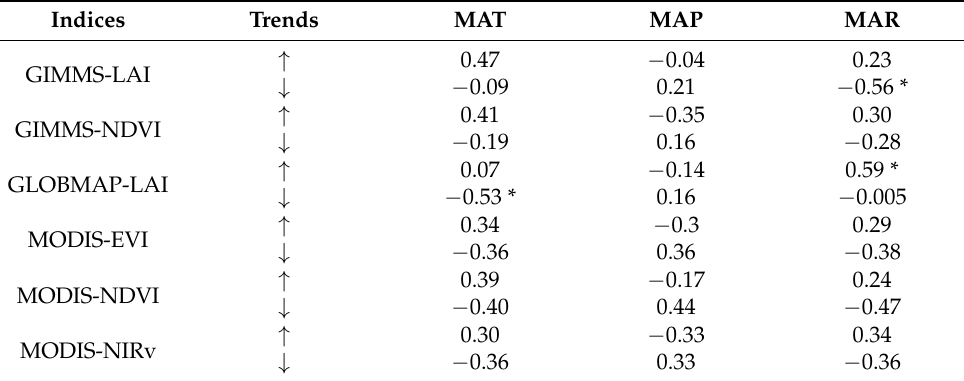
Table 2. Correlation between climate factors and changes in vegetation indices.